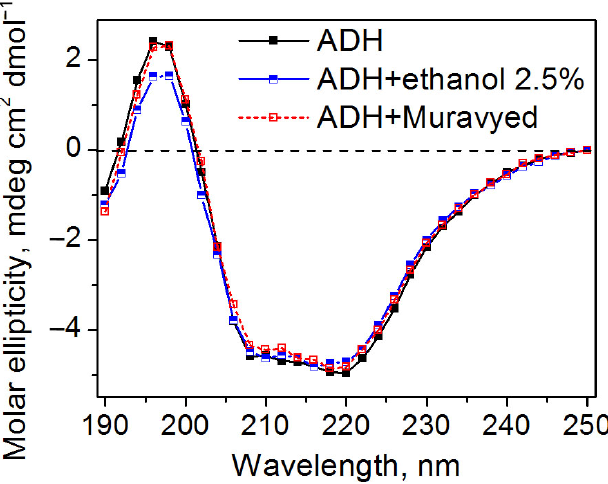
Figure 7. Circular dichroism spectra of ADH without additives (black) and in the presence of ethanol (blue) and the Muravyed commercial pesticide formulation (red). ADH concentration was 0.1 mg/mL, diazinon concentration in Muravyed was 0.02 mg/mL. Neither ethanol nor Myravyed alters the secondary structure of ADH.